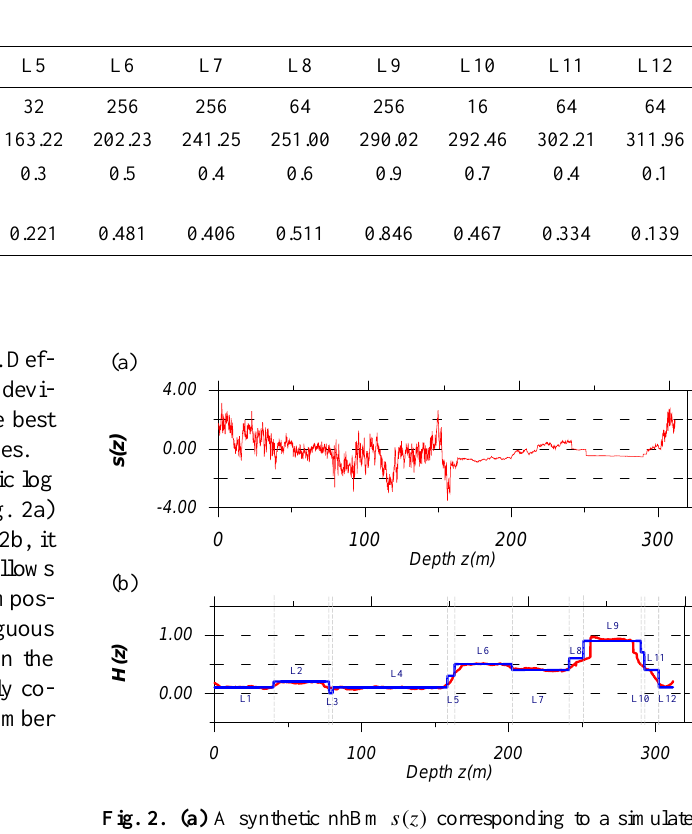
Table 3. Simulated multi-layer geological model parameters.